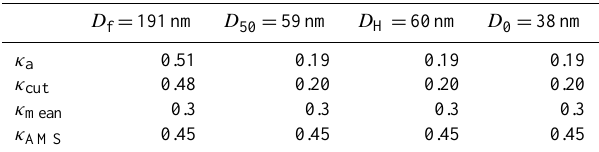
Table 1. Different combinations of hygroscopicity parameters ( κ a ,κ cut ,κ mean , κ AMS ) and activation threshold diameters ( D f , D 50 , D H , D 0 ) used to determine the cloud peak supersaturations reported in Table 2 by Köhler theory calculations as detailed in Ap- pendices A and